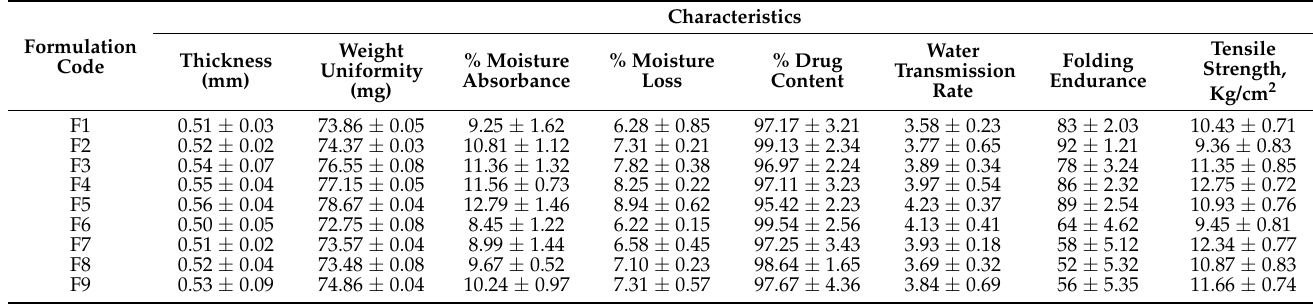
Table 2. Characterization of MTX-loaded transdermal patches (F1–F9). Data were expressed as mean ± SD, n = 3.